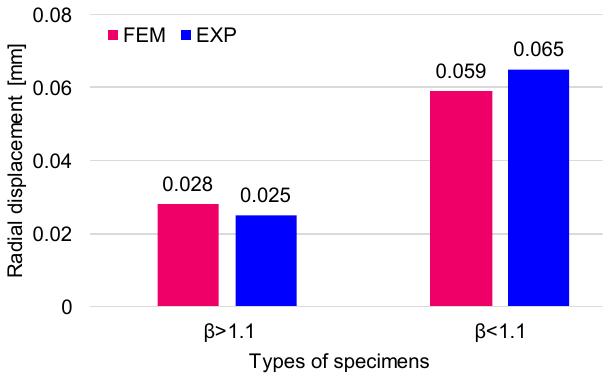
Figure 9. Comparison between finite element method (FEM) and experimental (denoted EXP) results. Comparing the results of the numerical model (FEM) and experiments, it can be noticed that their differences range between 0.3 and 0.6% (Figure 9). In Figure 10, the stress and displacement distribution are shown for each analysed case.